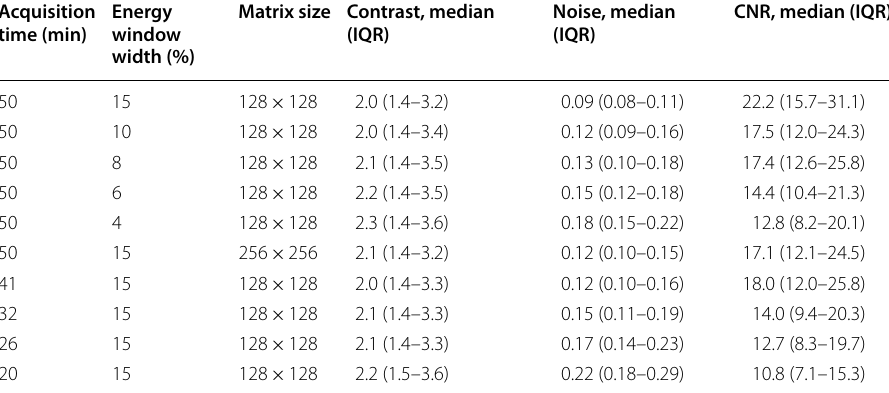
Table 2 Contrast, noise, and CNR of images with different acquisition parameters Acquisition Energy time (min)